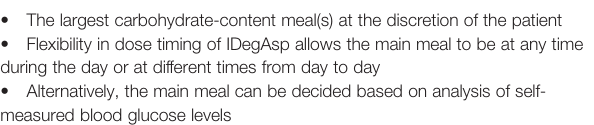
TABLE 1 | Expert Panel Recommendation 1: Main meal concept. (cid:129) The largest carbohydrate-content meal(s) at the discretion of the patient (cid:129) Flexibility in dose timing of IDegAsp allows the main meal to be at any time during the day or at different times from day to day (cid:129) Alternatively, the main meal can be decided based on analysis of self- measured blood glucose levels